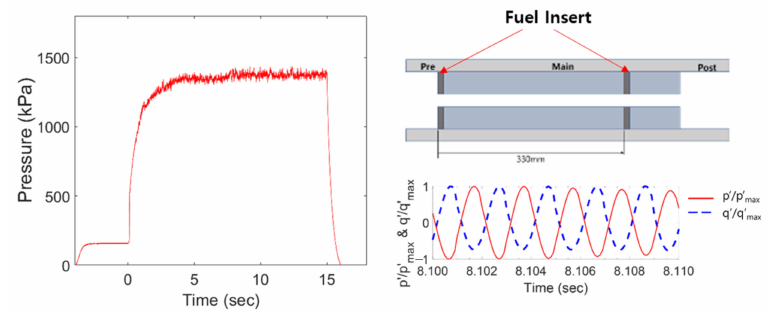
Figure 7. Combustion pressure and normalized p (cid:48) and q (cid:48) from test 2.